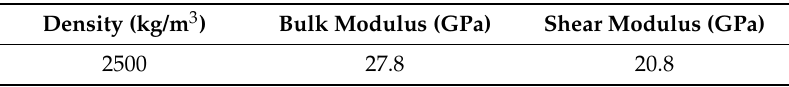
Table 2. Physico-mechanical properties of the rock